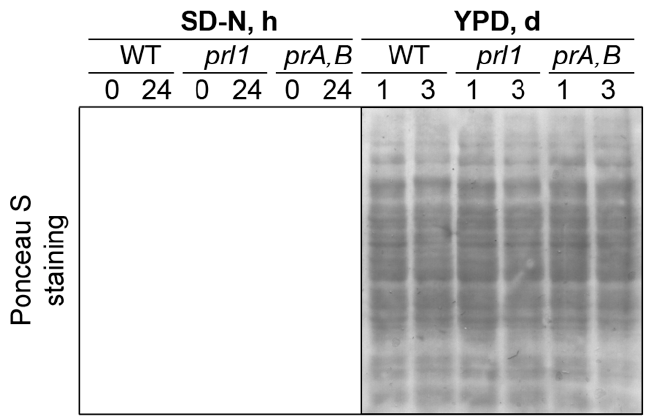
Figure A1. Supplemental figure for Figure 3. Loading control (see Figure 3 for details).